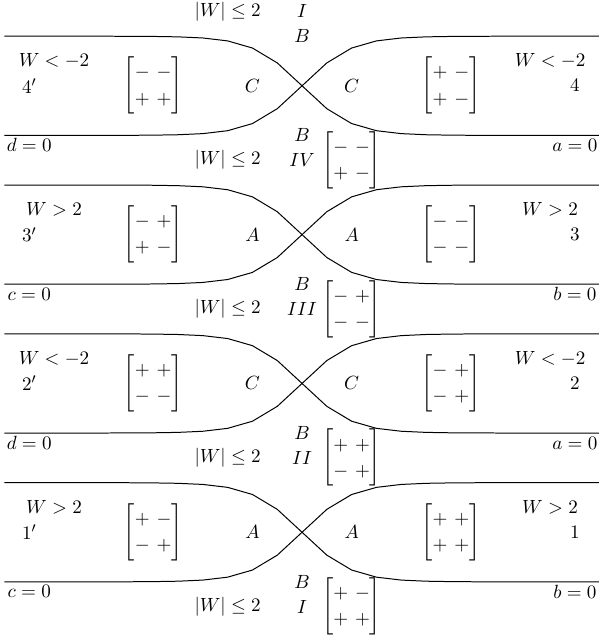
Figure 2 . Two dimensional slice of SL(2 ; R